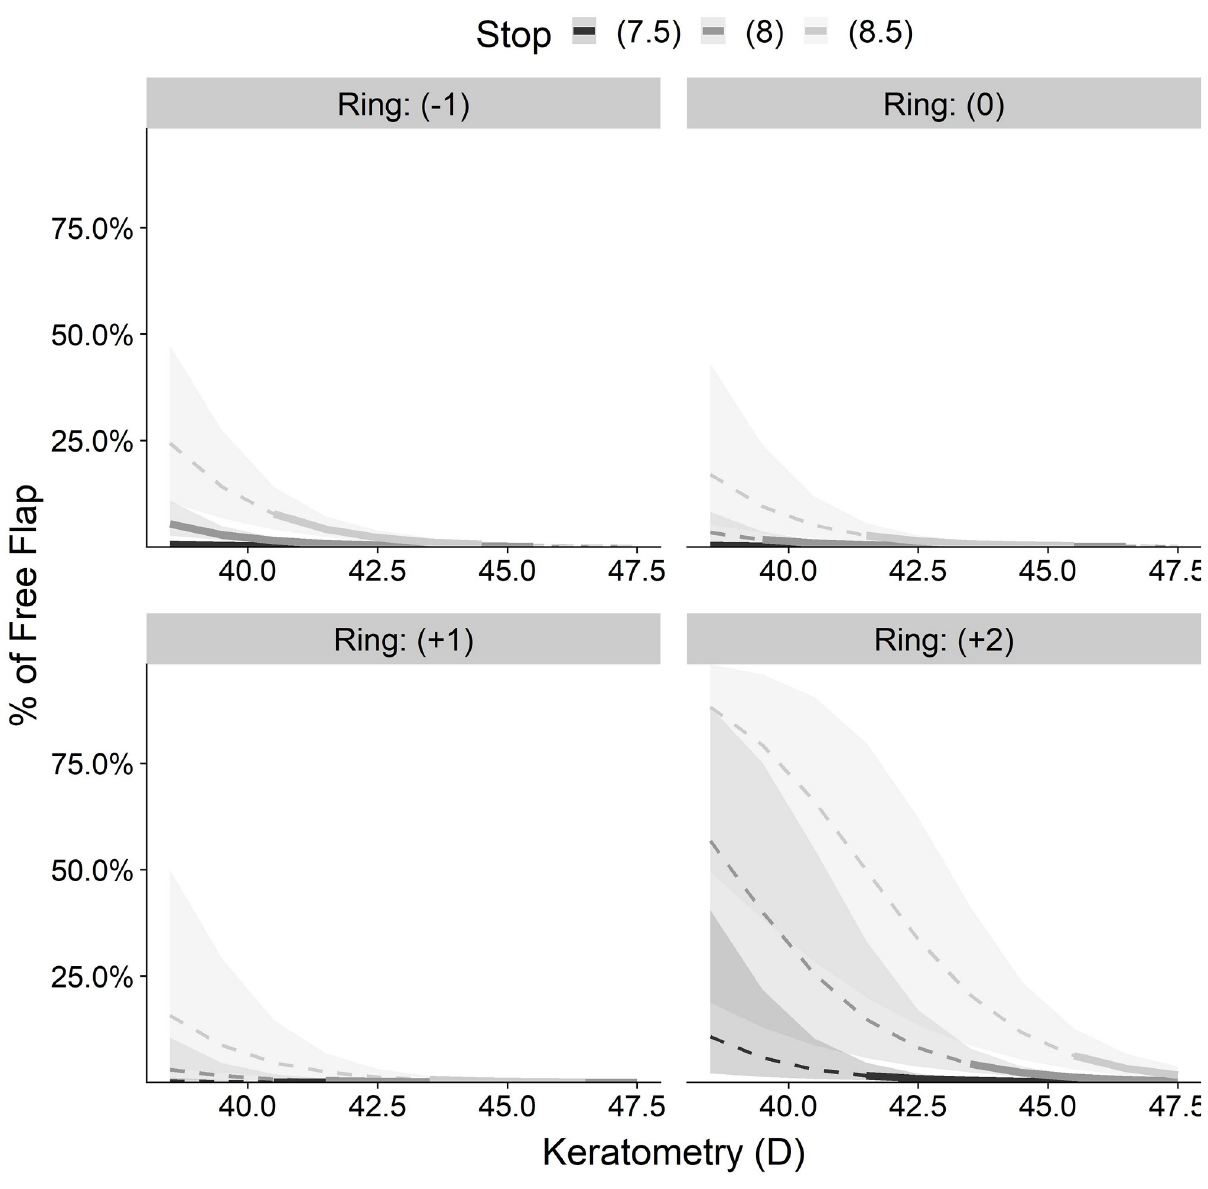
Fig 7. Predicted incidence of free flap by